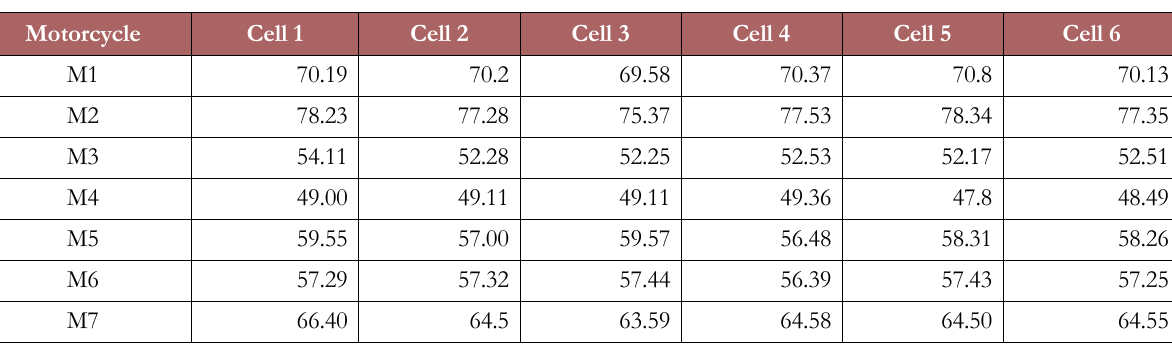
Table 5. Standard time T